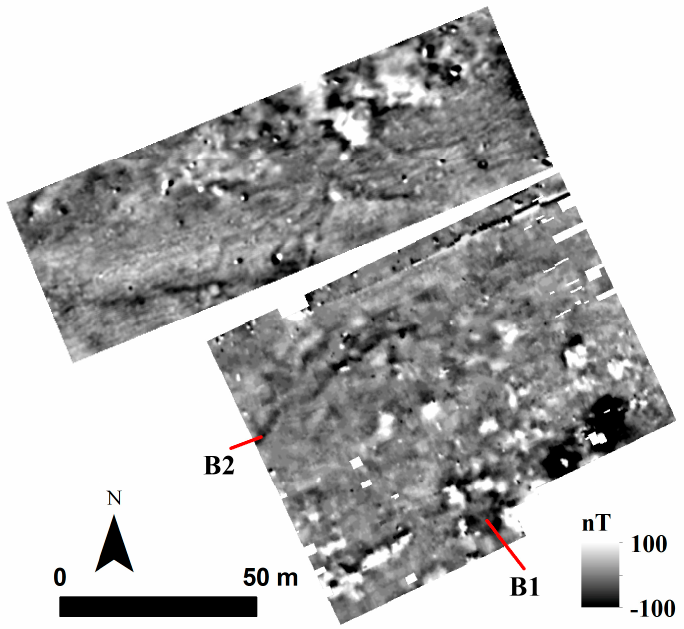
Figure 7. Geomagnetic prospection results from Kamara.